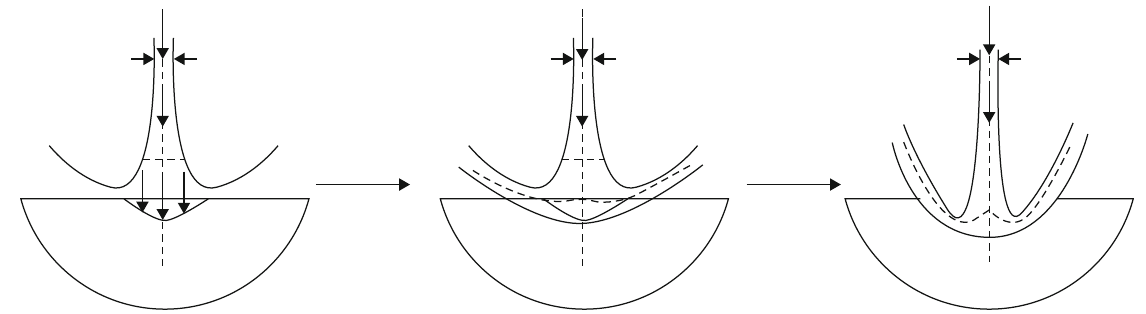
Figure 4: Rock fracture mechanism of the high-pressure water jet.